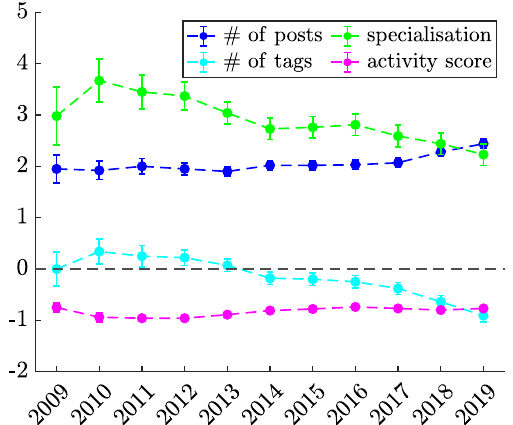
Figure 4. Logistic regression results for the probability that a user has at least one accepted answer in a given year. Dots represent the values of the regression coefficients estimated for the four covariates included in the model, shown in the legend. Error bars show the standard errors on the coefficients times